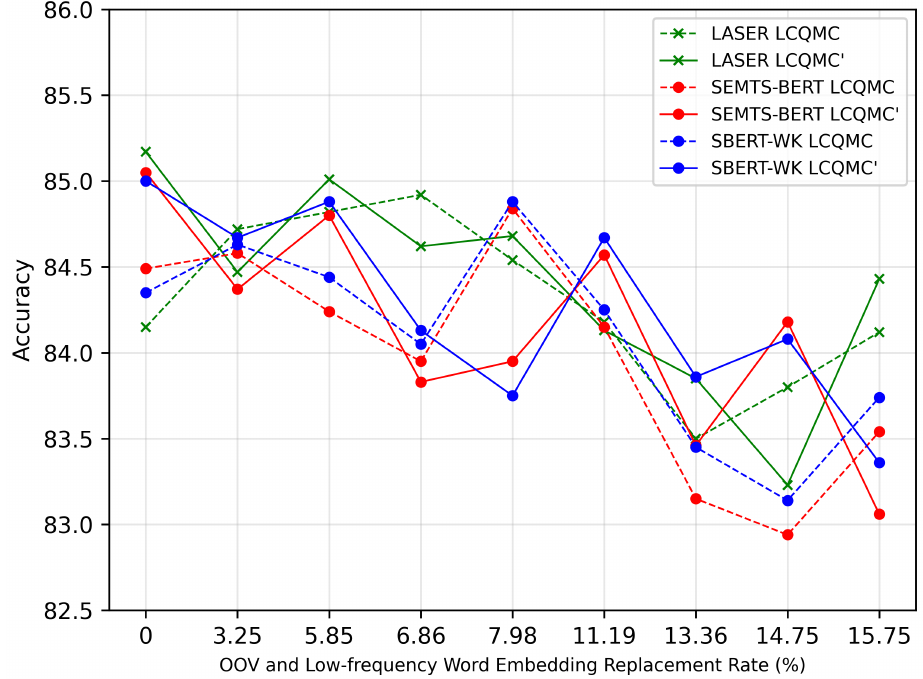
Figure 13. The influence of initial performances (low-frequency word embedding replacement rate is 0) on BiMPM performance at different replacement rates. We take evaluation on LCQMC as an